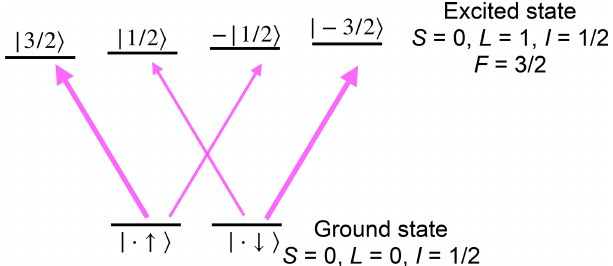
Figure 11. Energy level system and resonance lines of a Zeeman doublet.